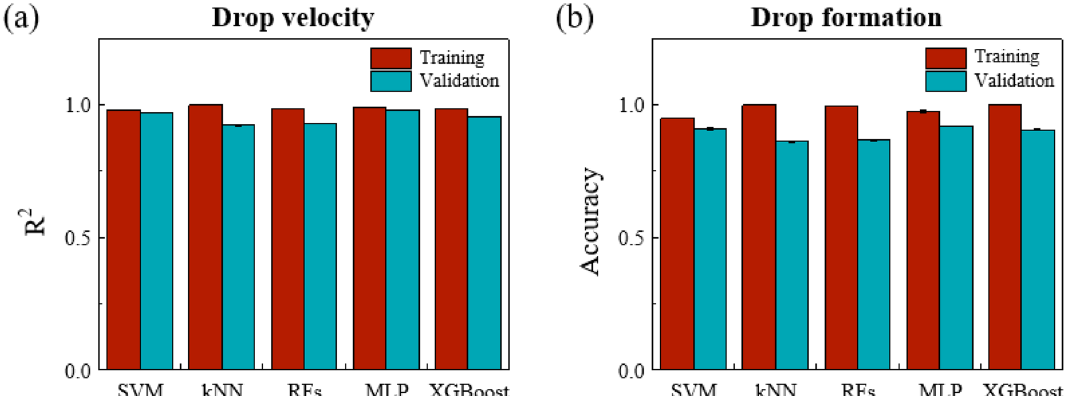
Figure 3. Performance evaluation of 5 machine learning models in predicting drop velocity and drop formation. ( a ) coefficient of determination of predicting drop velocity ( b ) accuracy of predicting drop formation. SVM, Support Vector Machine; kNN, k-nearest neighbors; RFs, random forests; MLP, Multi-layer Perceptron; XGBoost, extreme gradient